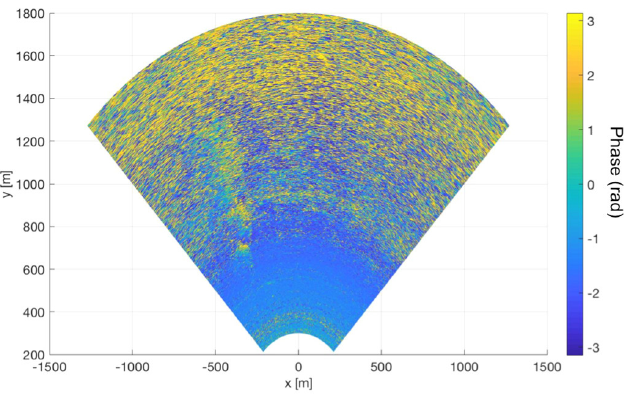
Figure 20. Radar image obtained with 33% of data and CS.